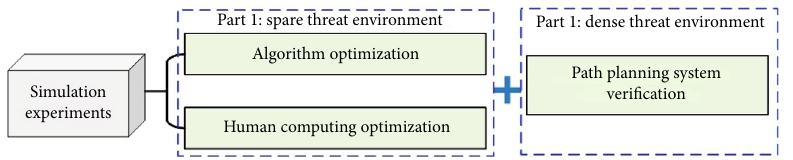
Figure 17: Structure of the simulation. Table 1: The information of threat areas.